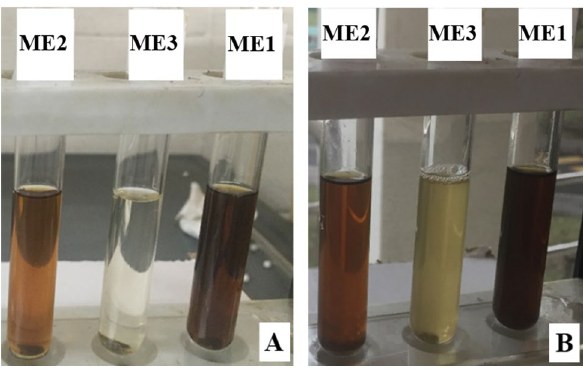
Fig. 3 Mixed scale deposit Sample 1 in different solutions of micro-